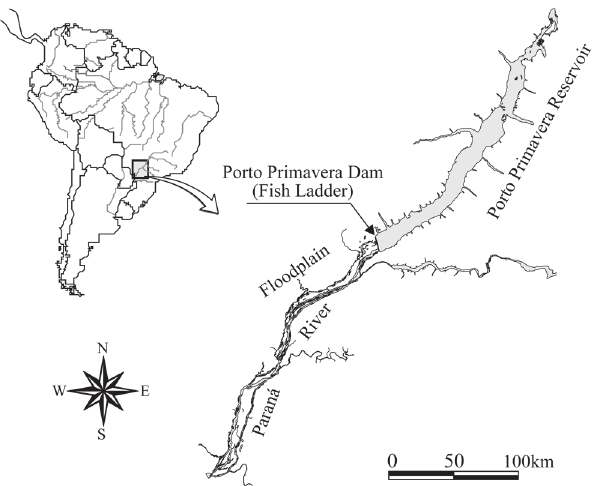
Fig. 1. Location of Engenheiro Sérgio Motta (Porto Primavera) Hydroeletric Power Plant, Paraná River, Mato Grosso do Sul, São Paulo States,